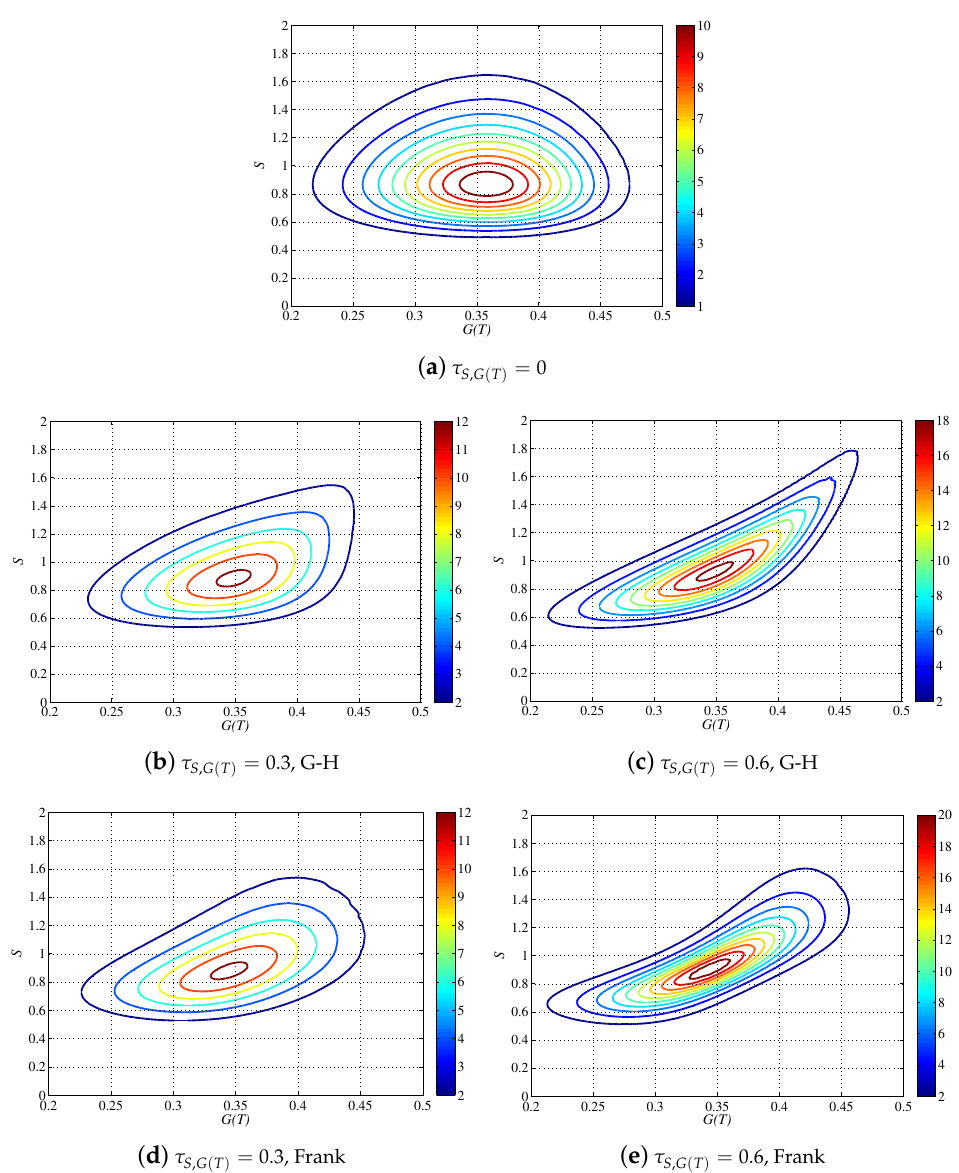
Figure 3. Contour plots of the joint PDF of S and G ( T )